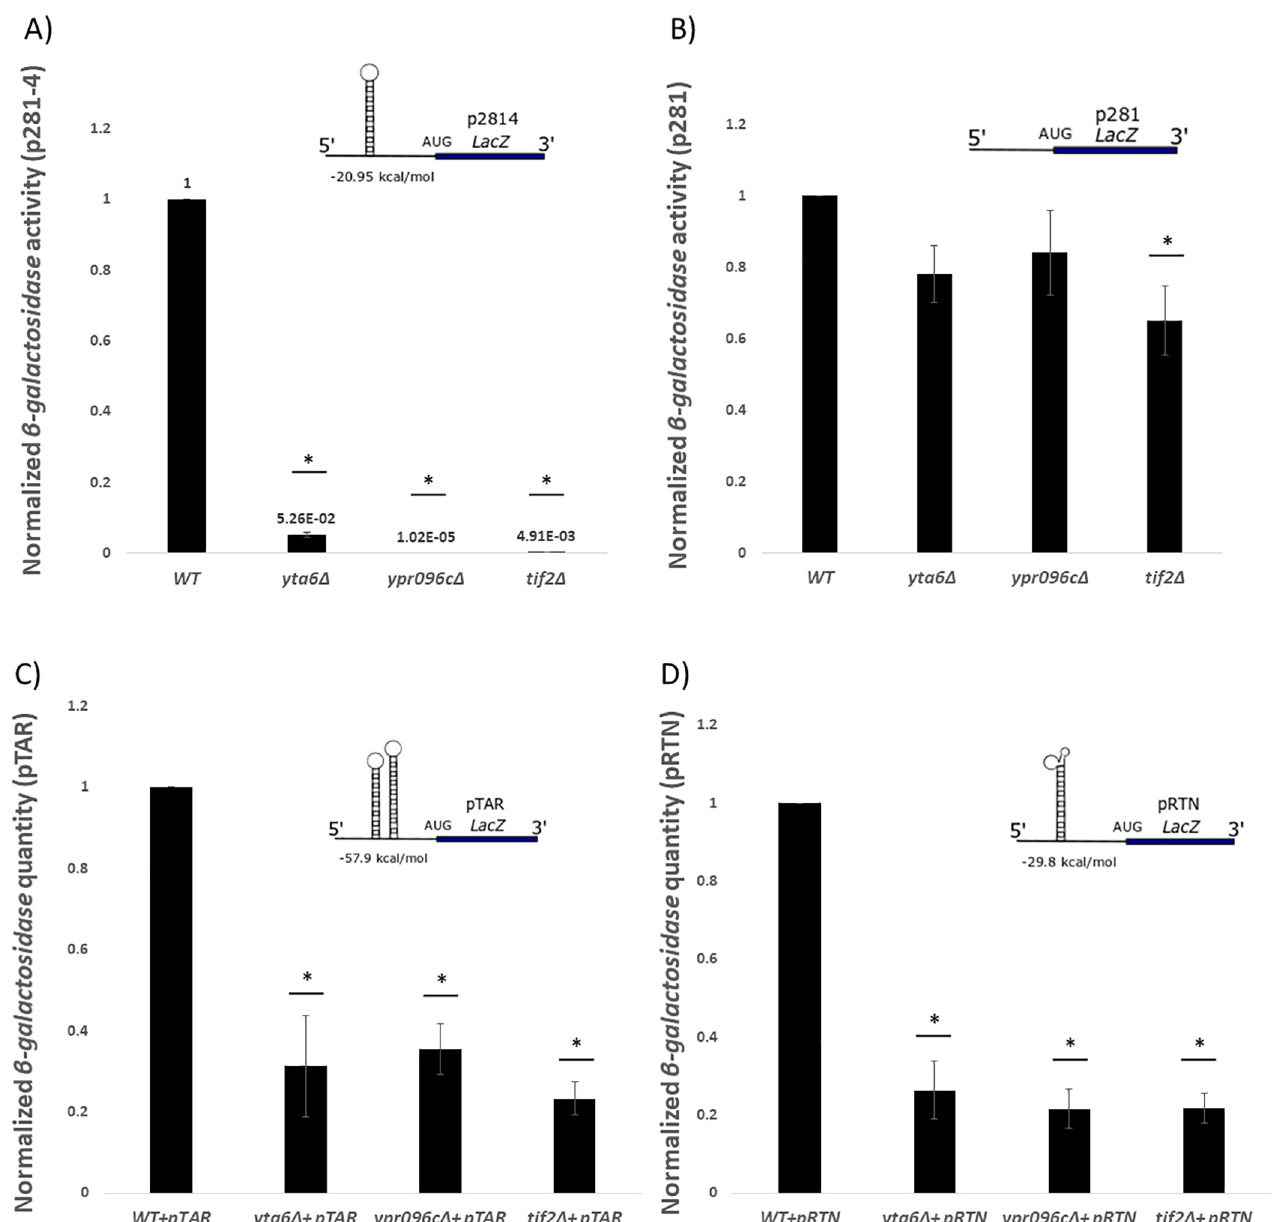
Fig 5. Normalized β -galactosidase activity is lower in yta6 Δ and ypr096c Δ for structured mRNAs. A strong hairpin structure (p281-4) (A) upstream of a LacZ reporter pTAR (C) highly structured 5’-UTR of HIV1-tar and pRTN (D) constructs contain the highly structured 5’-UTR of FOAP-11 genes in front of the β -galactosidase reporter mRNA. P281 (B) was served as a control plasmid with no inhibitory structure did not show as significant reductions in β - galactosidase activity. Values are normalized to that for WT which resulted in average β -galactosidase values of 14.1U and 37.9U for pRTN and p416 constructs, respectively. Each experiment was repeated at least three times (n � 3) and error bars represent standard deviation. � represent statistically significant results ( P -value � 0.05) compared to the WT. t-test analysis ( P -value � 0.05) was used to compare differences. The insets represent schematic reporter mRNA